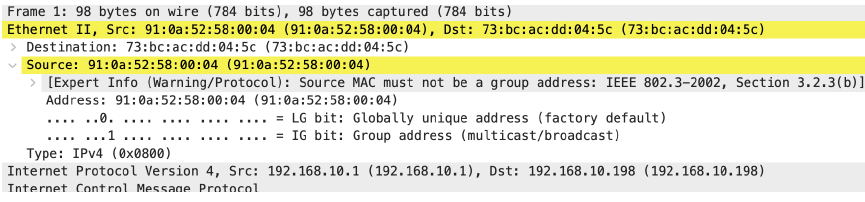
Figure 2. Example of incompatibility to